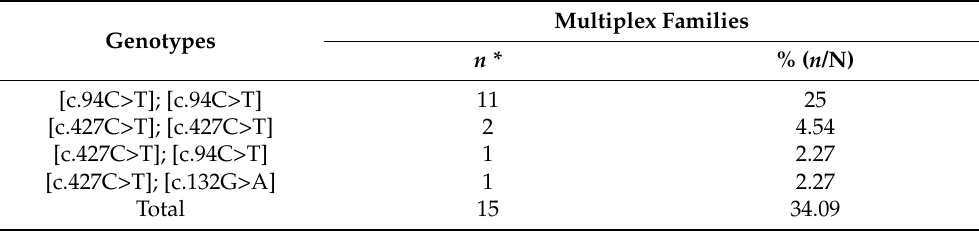
Table 2. GJB2 pathogenic variants among 15/44 multiplex families with congenital ARNSHI.